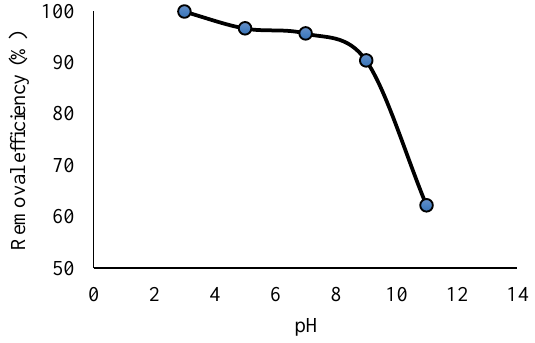
Fig. 6. Effect of solution pH on removal efficiency of Direct Blue 15 using EDTA/chitosan-modified MWCNT nanocomposite (adsorbent dose: 0.5 g/L, contact time: 60 min, initial dye concentration: 60 mg/L)